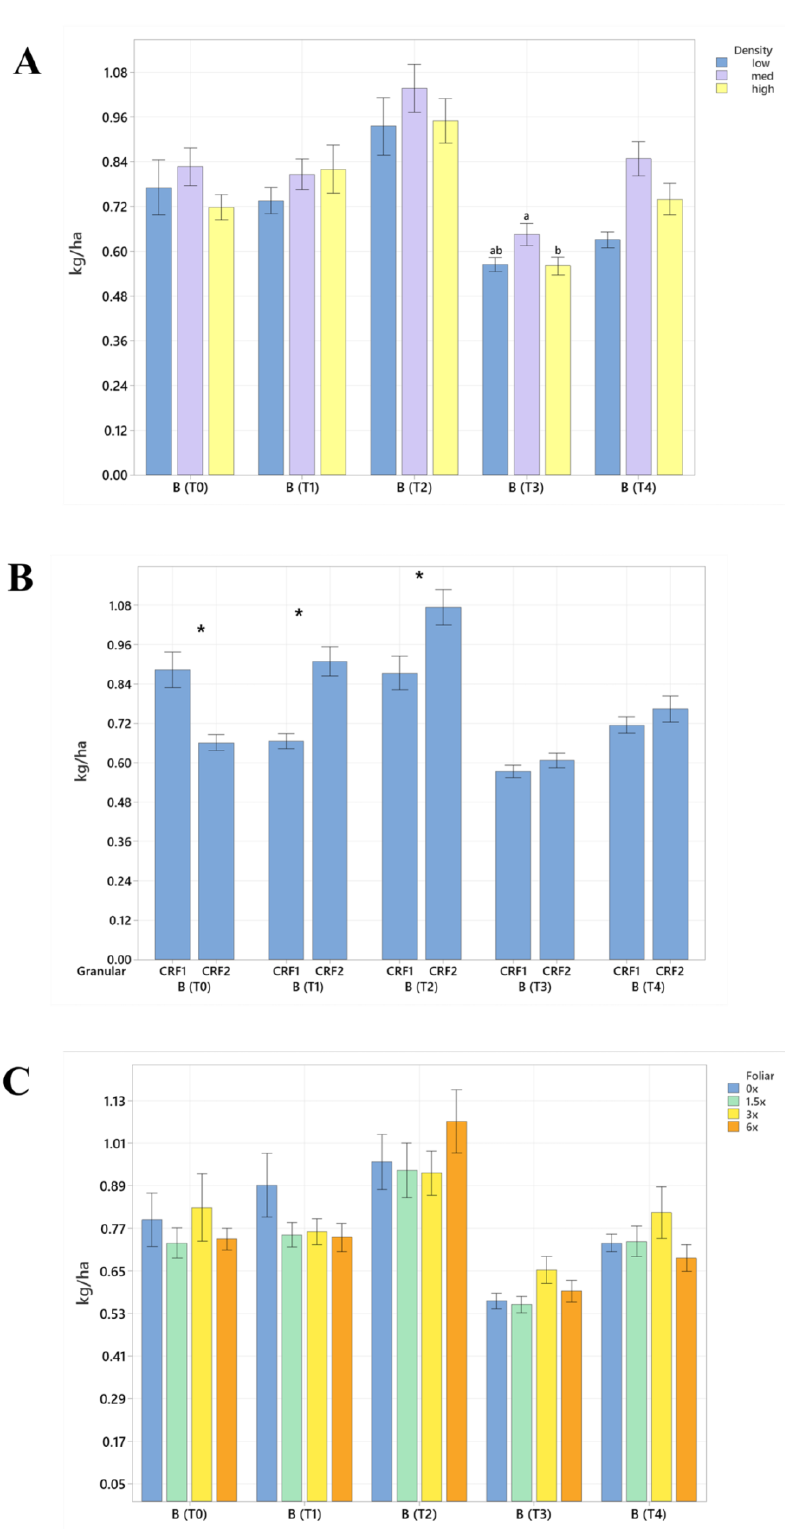
Figure 4. Soil boron concentrations of ‘Ray Ruby’ grapefruit grafted on ‘Kuharske’ citrange planted in flatwood soils located in Fort Pierce, FL, USA, in response to ( A ) planting density, ( B ) ground-applied fertilizer and ( C ) foliar fertilizer treatments during September 2020 (T0), January 2021 (T1), May 2021 (T2), September 2021 (T3) and January 2022 (T4). Bars are ± standard deviation of the mean. Treatments with * and different letters were considered to be significantly different ( p <